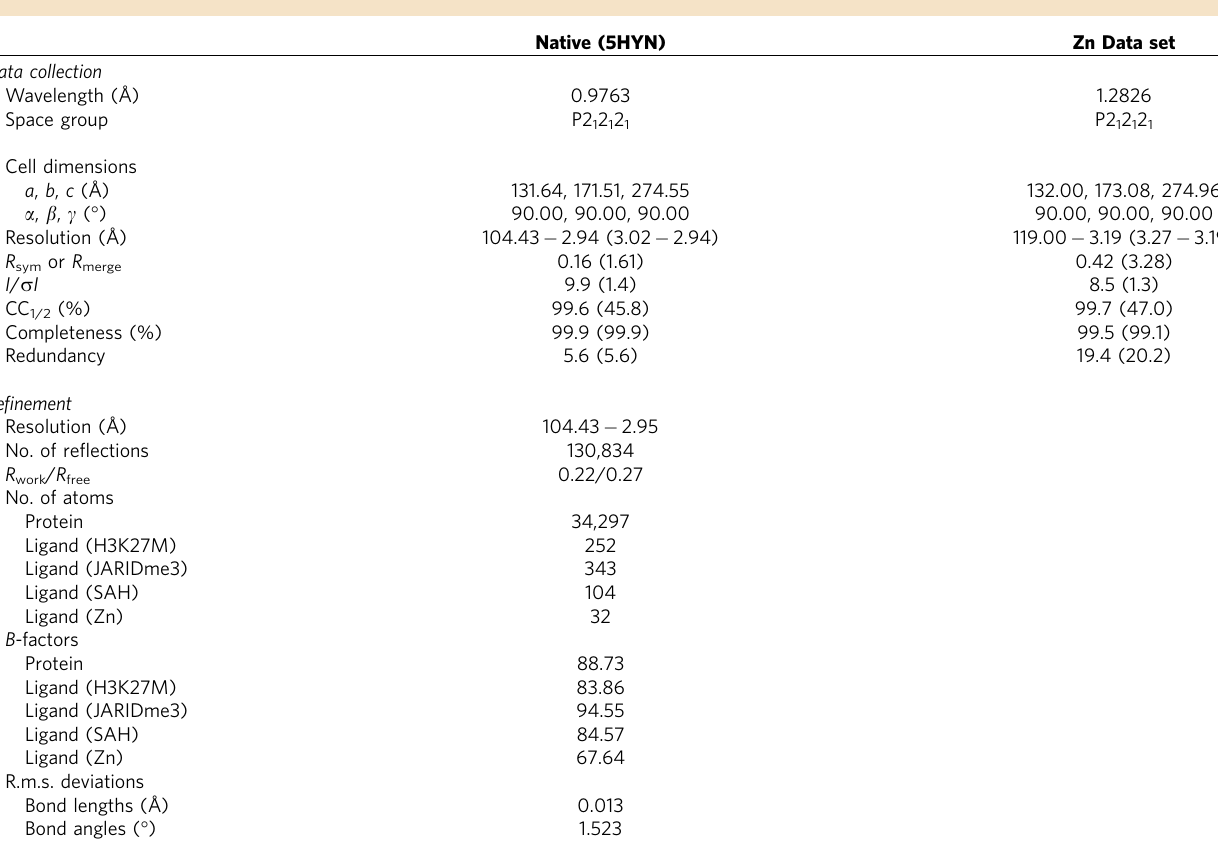
Figure 1 | Overall structure of the human PRC2 complex. ( a ) Structure of the catalytically active core of PRC2 in cartoon representation. ( b ) Orthogonal view. ( c ) Stylized surface representation showing the relationship of the three lobes of PRC2. The N lobe consists of EED and the N-terminal region of EZH2. The middle lobe of the SUZ12 Vefs and EZH2 MCSS and SANT2. The catalytic lobe comprises the post SETand SETdomains and a hairpin formed by the region of Suz12 N-terminal to the Vefs. Superposed is a cartoon indicating the activating Jarid2 peptide (yellow), which stabilizes the SRM region (pink), which in turn stabilizes the SET-I helix (blue) and thus completes the active site where substrate peptide (green) is bound. ( d ) Schematic representation of the domain architecture of PRC2 showing the composition of the complex. The distinct subdomains discussed in the main text and shown in a , b are indicated by the coloured Table 1 | Data collection and refinement statistics.